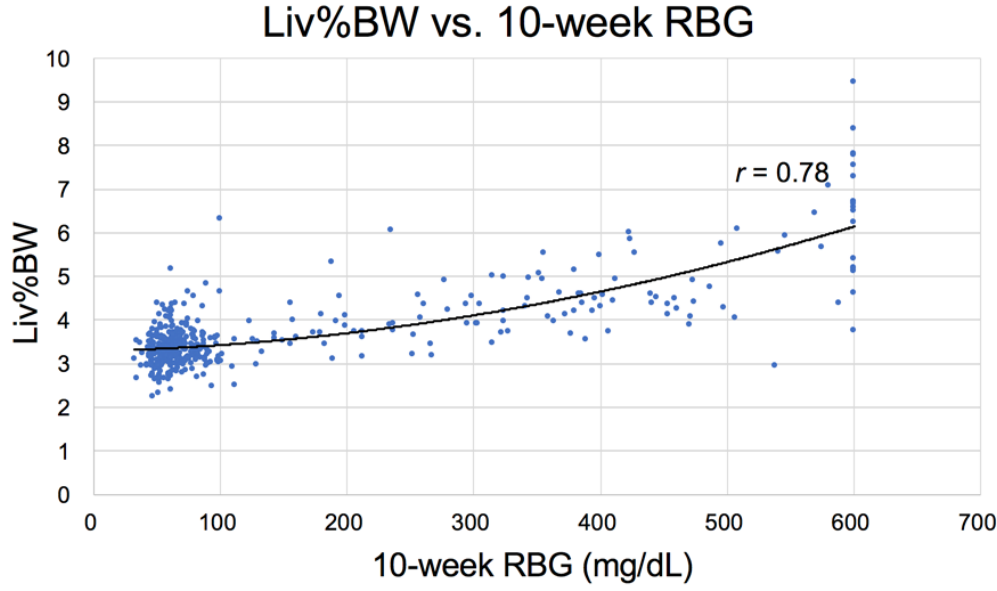
Figure 10. Strong correlation exists between random blood glucose (RBG) and liv%BW at necropsy (10 weeks of study) ( n = 439). This reflects fatty liver development as diabetes progresses (see Figures 4B and 5A). Blood glucose values exceeding 600 mg/dL are not recorded by the glucometer.